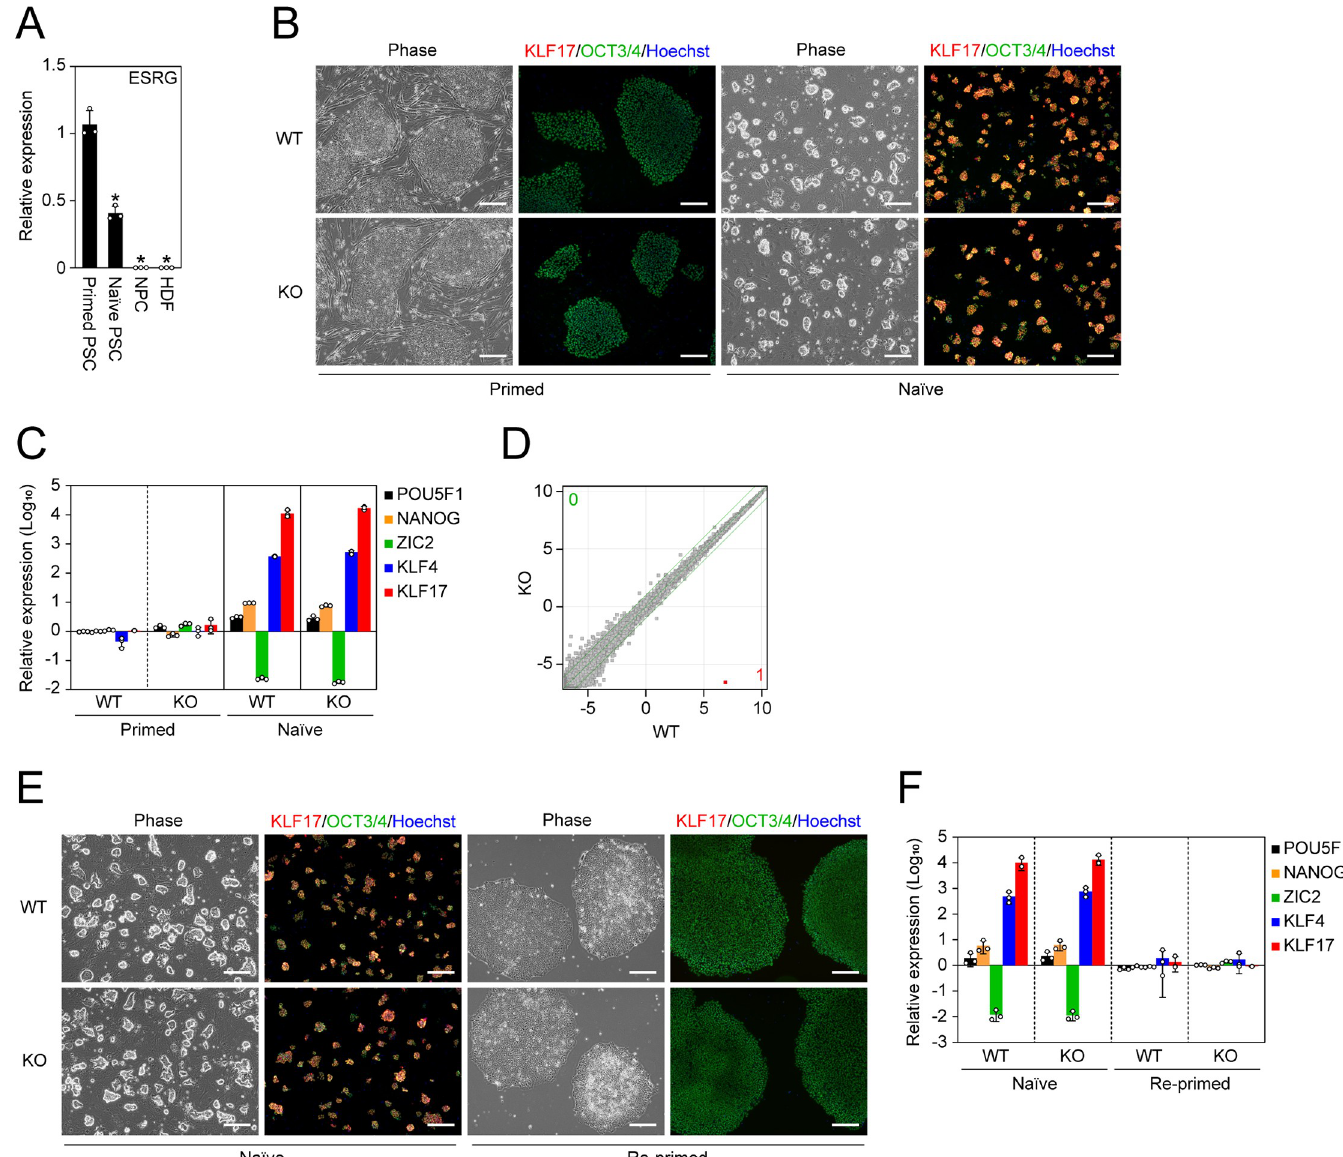
Fig 3. No impact of ESRG on na ï ve pluripotency. (A) The ESRG expression. Shown are relative expressions of ESRG in primed PSCs, na ï ve PSCs, NPCs and HDFs. Values are normalized by GAPDH and compared with the primed 585A1 iPSC line. � P < 0.05 vs. primed PSCs by unpaired t-test. n = 3. (B) Conversion to na ï ve pluripotency. Shown are representative images of ESRG WT and KO primed and na ï ve PSCs under phase contrast and of immunocytochemistry for KLF17 (red) and OCT3/4 (green). Bars, 200 μ m. (C) The expression of primed and na ï ve PSC markers. Shown are the relative expressions of common PSC markers (POU5F1 and NANOG), a primed PSC marker (ZIC2) and na ï ve PSC markers (KLF4 and KLF17). Values are normalized by GAPDH and compared with primed H9 ESCs. n = 3. (D) Global transcriptome. Scatter plots comparing the microarray data of ESRG WT and KO na ï ve PSCs. The colored plot indicates DEG with statistical significance (FC > 2.0, FDR,0.05). The numbers of DEGs (FC > 2.0, FDR,0.05) are shown in the figure. n = 3. (E) Differentiation to primed pluripotency. Representative images of ESRG WT and KO na ï ve PSCs before and after conversion to the primed pluripotent state are shown. Bars, 200 μ m. (F) The expression of primed and na ï ve PSC markers. Shown are the relative expressions of the marker genes in (C) in ESRG WT and KO na ï ve PSCs before and after the differentiation to the primed pluripotent state. Values are normalized by GAPDH and compared with primed H9 ESCs. n = 3. Numerical values for A, C, and F are available in S1 Data.